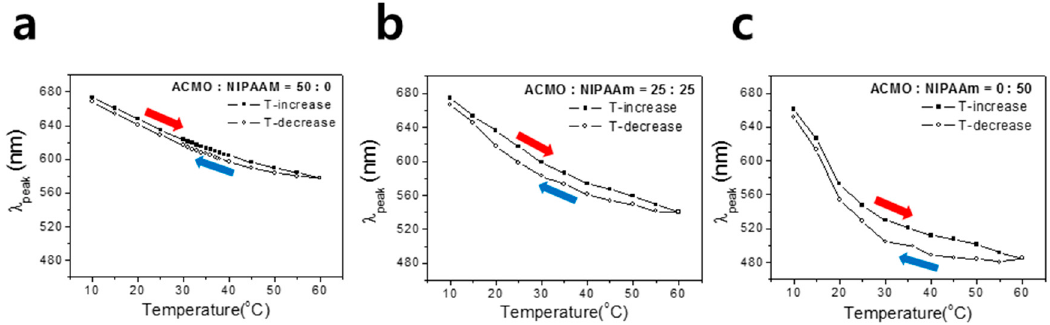
Figure 7. Hysteresis plots of the temperature-dependent stopband positions ( λ peak ) of three different IO photonic gels with relative ACMO contents of ( a ) 100%, ( b ) 50%, and ( c ) 0%. Heating and cooling rate was set as 5 °C/min, and equilibrated for 30 min at each designated temperature before optical measurements.